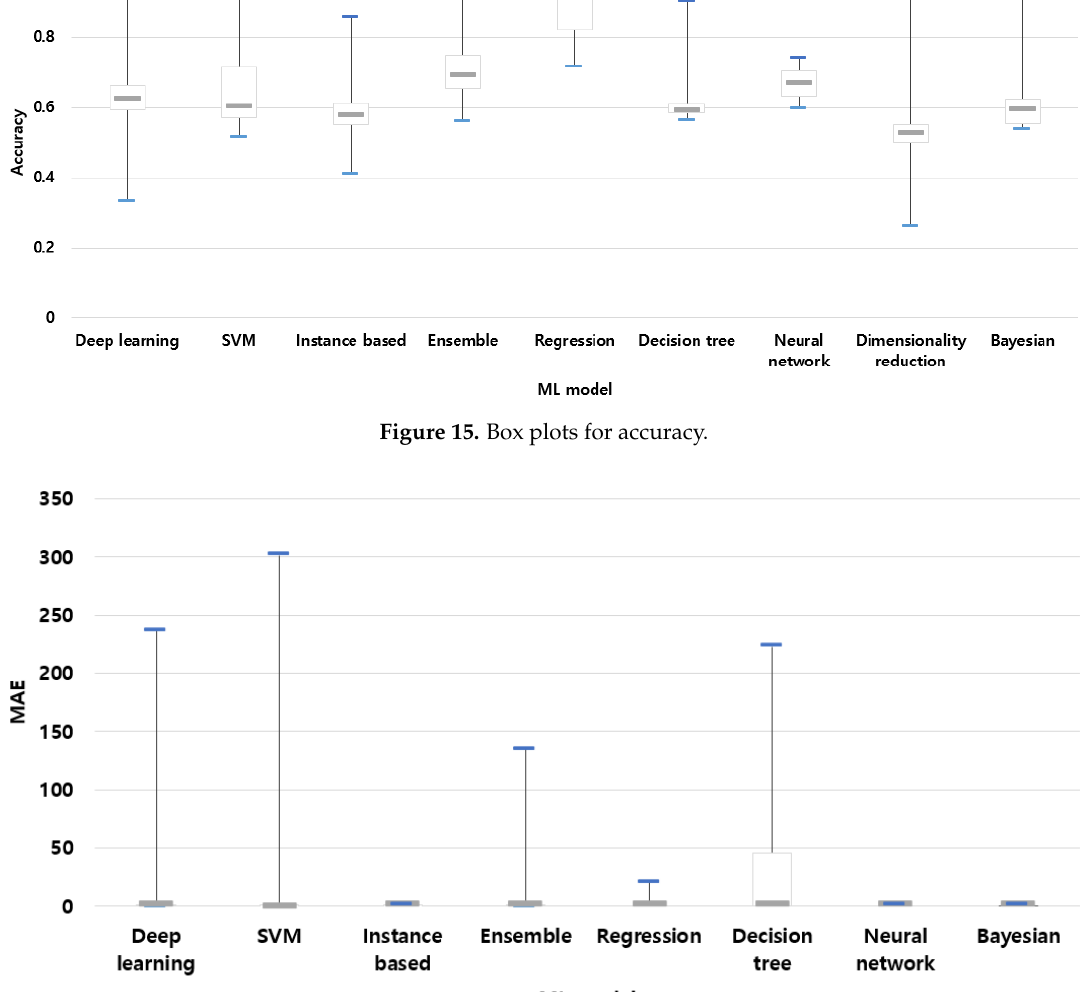
Figure 16. Box plots for MAE.